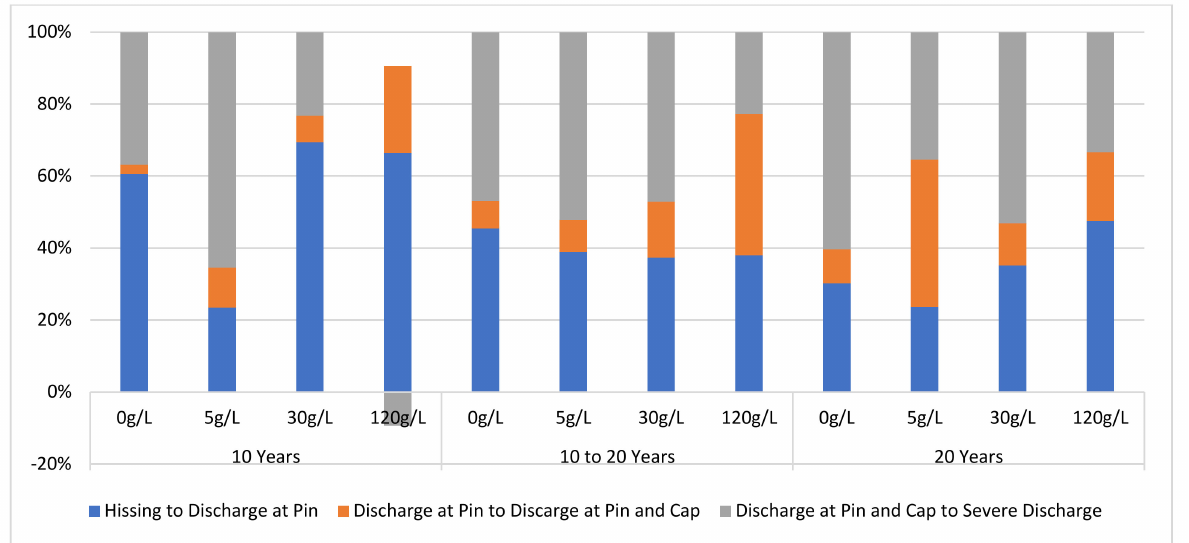
Figure 12. Average percentages are different between discharge intensity